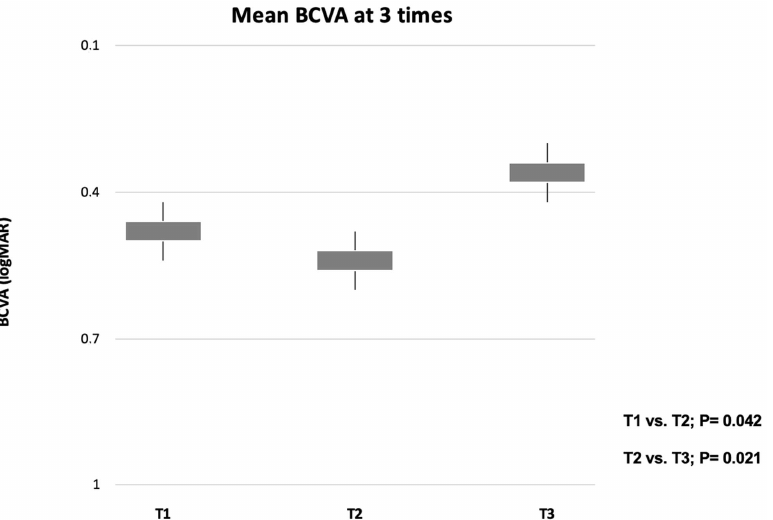
Figure 2. Box and whisker plots showing analyzed BCVA measurements at each time. The ends of the whiskers represent the minimum and maximum values.